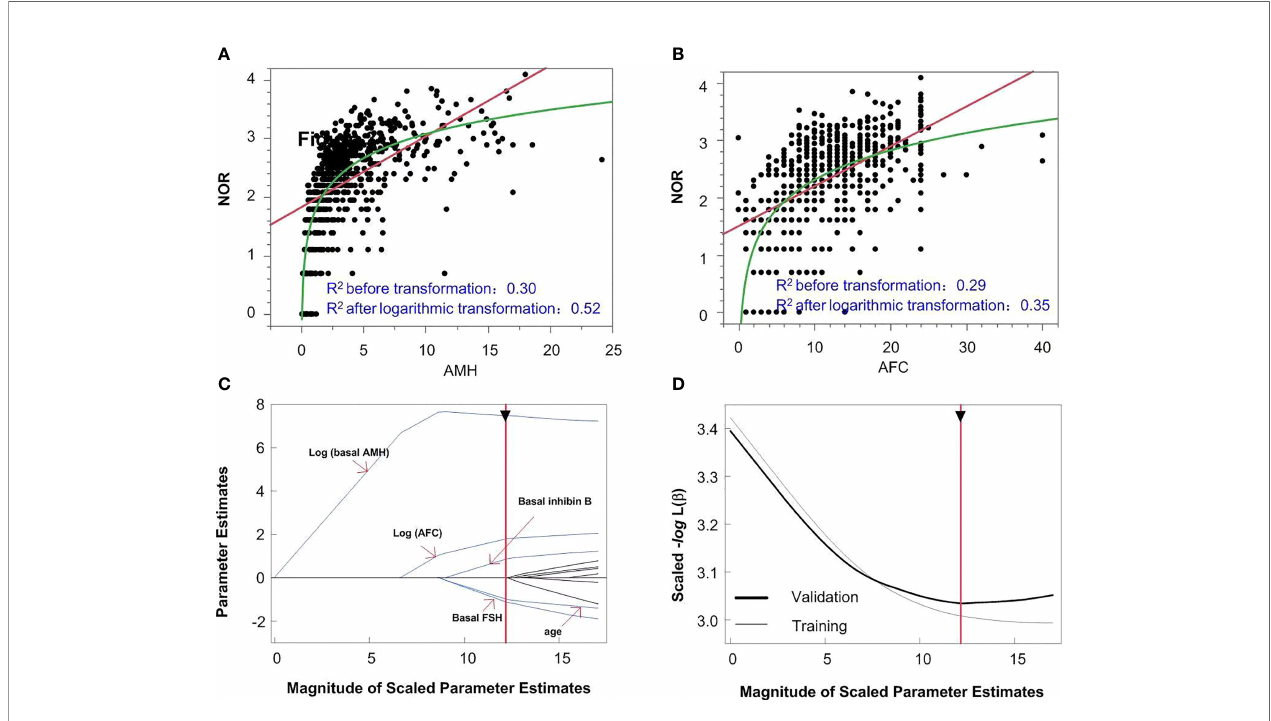
FIGURE 3 | The model building process of Model 1. logarithmic or linear correlation between independent variables of AMH (A) and AFC (B) and outcome variables are shown in panels A and (B) The variable selection process is shown in panels (C, D) When fi ve variables were included (C) , the scaled - Log L ( b ) in the validation set no longer decreased (D) .